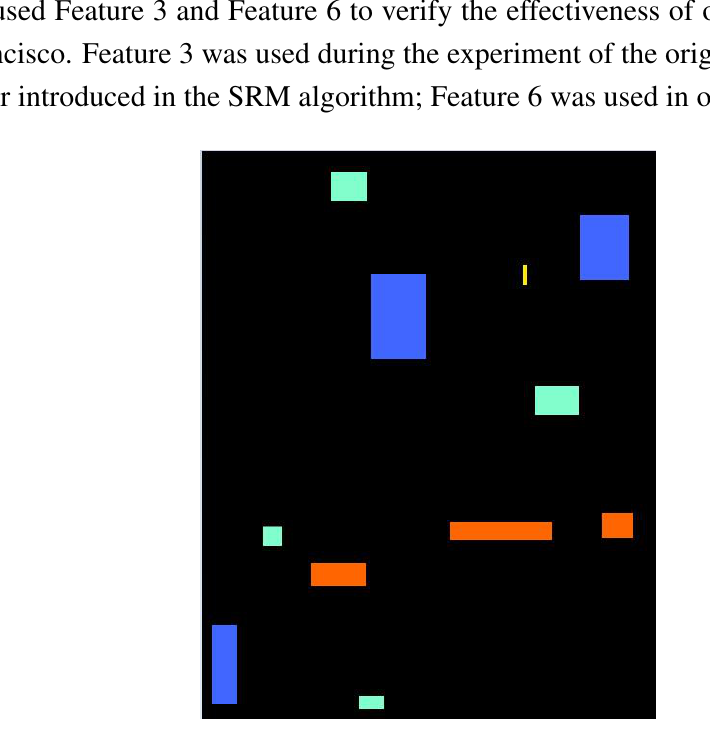
Figure 22. The illustration of the training samples for the San Francisco